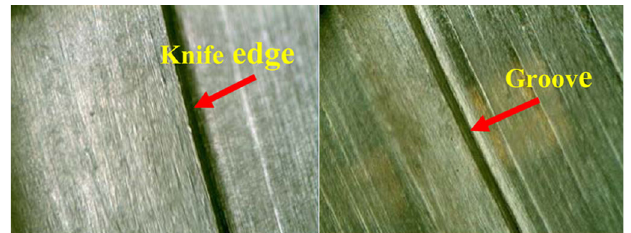
FIG. 4. (Color) Close-up pictures of NbZr knife edge and niobium gasket groove. Both surfaces are less than